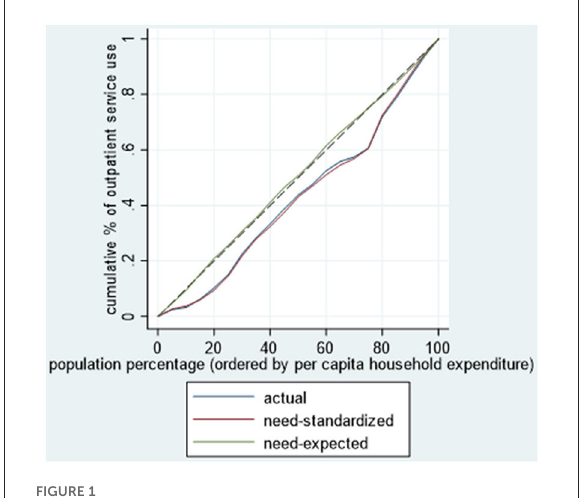
FIGURE1 Concentration curve for use of outpatient visits among cancer patients.